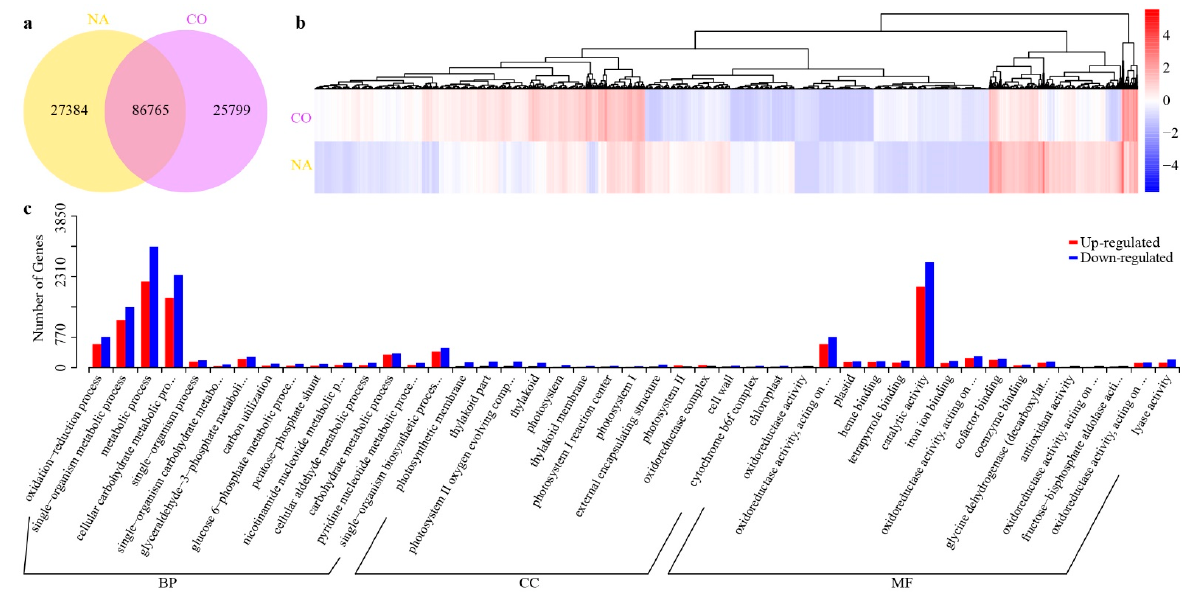
Figure 2. Expression analysis of unigenes. ( a ) Numbers of unigenes expressed in CO (Control) and NA (NaCl stress) conditions. ( b ) Diagram of the 10,452 differentially expressed unigenes (DEGs), the blue to red colors represents low to high relative expression levels. ( c ) GO enrichment of the up-regulated (red columns) and the down-regulated (blue columns) DEGs. BP, biological precesses; CC, cellular components; MF, molecular functions.